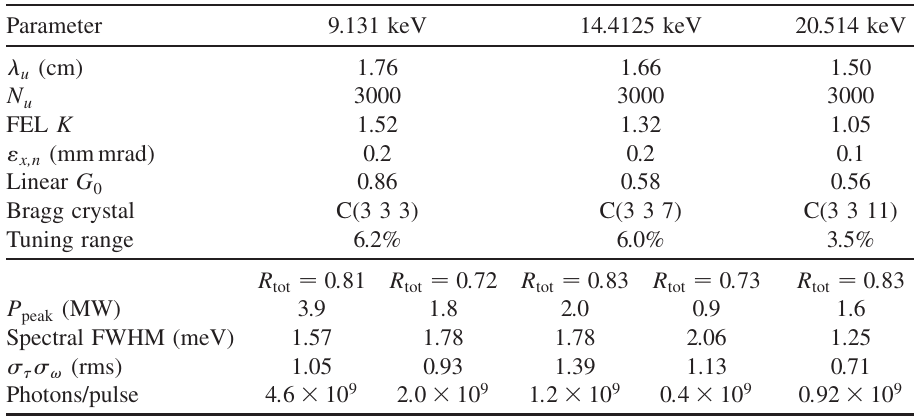
TABLE III. Possible undulator, beam, and optical cavity parameters for the 4-mirror, tunable ¼ 7 GeV , current I ¼ 20 A, energy FEL. For all cases the electron beam energy E beam beam ¼ 1 : 4 MeV , the rms beam length (cid:6) t ¼ 1 ps , while N u ¼ 3000 and the undulator gap spread (cid:6) E is 5 mm. The lower box contains radiation characteristics of the x-ray pulses that are couple through the thin mirror assuming 4% transmission, and include the ‘‘idealized’’ reflectivities on the left and the more conservative ones on the right, as described in the